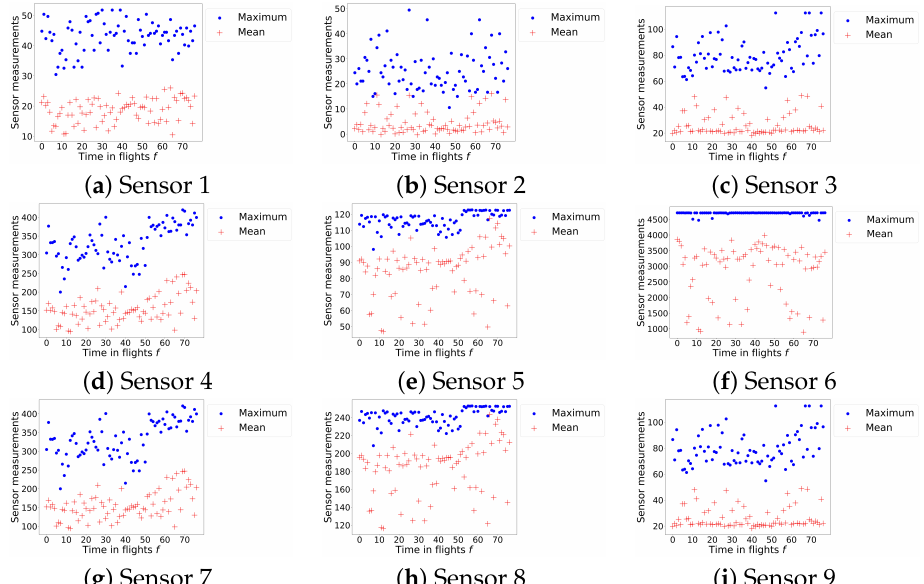
Figure 5. The mean and maximum sensor measurements per flight for one CU for all nine available sensors. The CU failed at flight